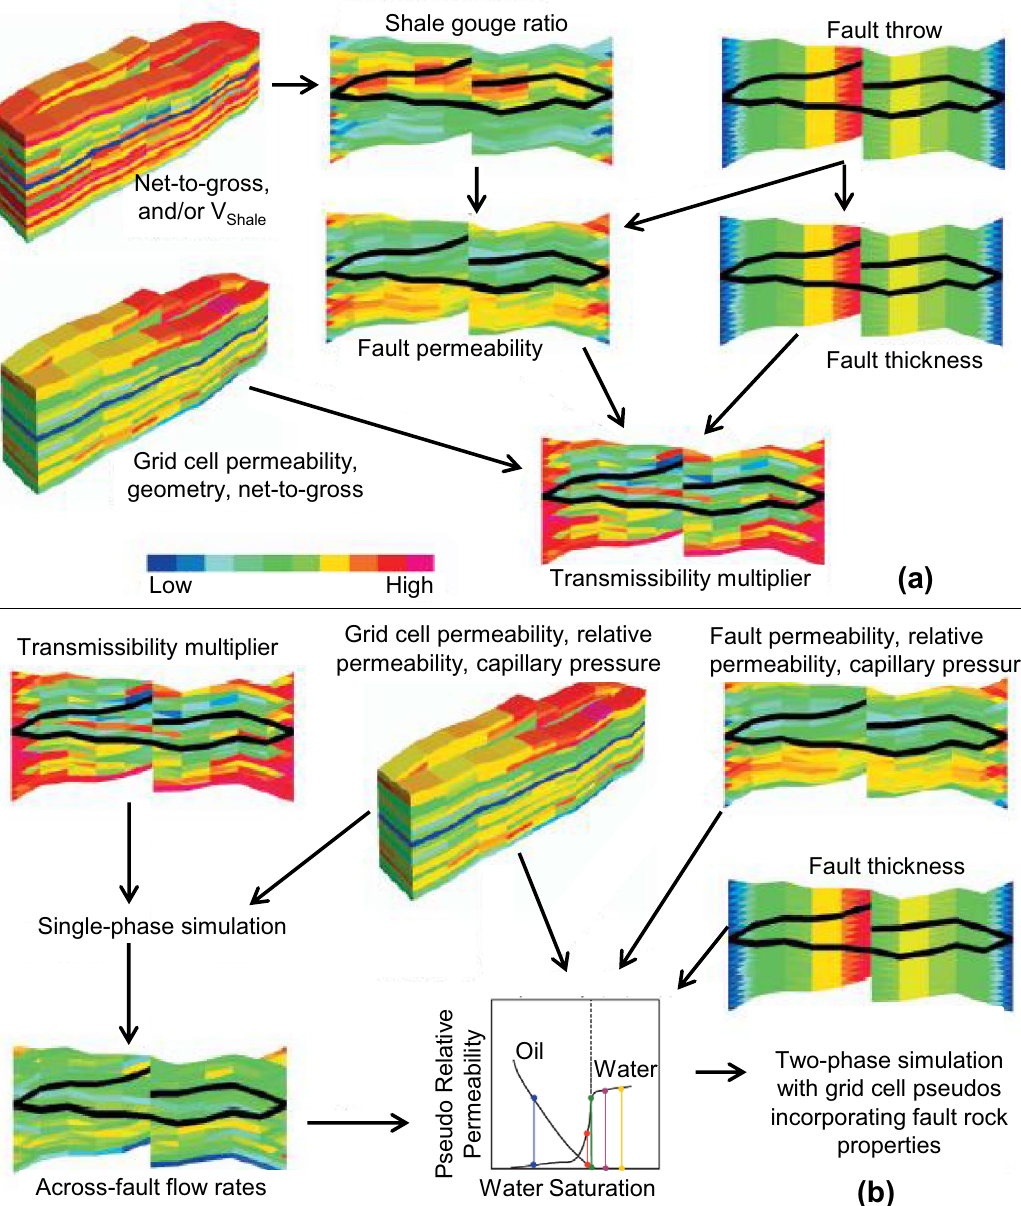
Figure 1. Workflow for incorporating ( a ) single-phase and ( b ) two-phase fault rock properties into flow simulation models. After Manzocchi et al. 1,7,11